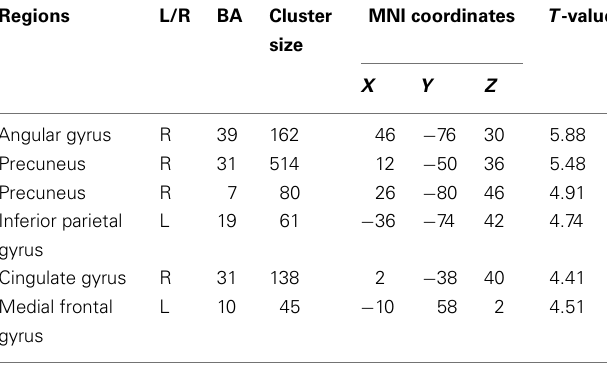
Table 1 | Brain regions that are deactivated during the gender judgment